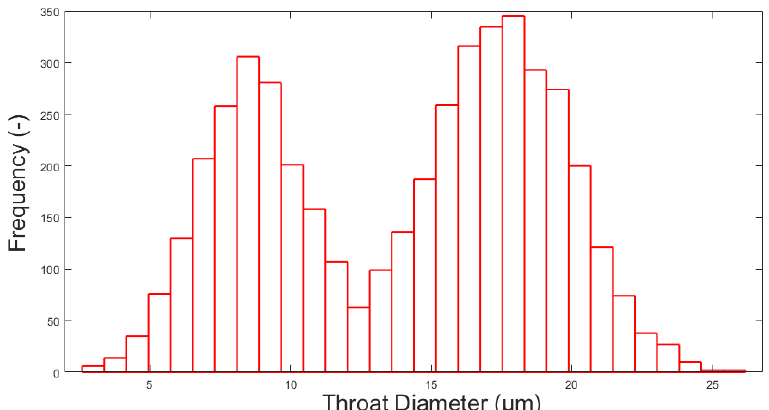
Figure 11. Bimodal throat size distribution with standard deviation 2.0 µ m for smaller (the first peak) and 2.5 µ m for larger (the second peak) throats.